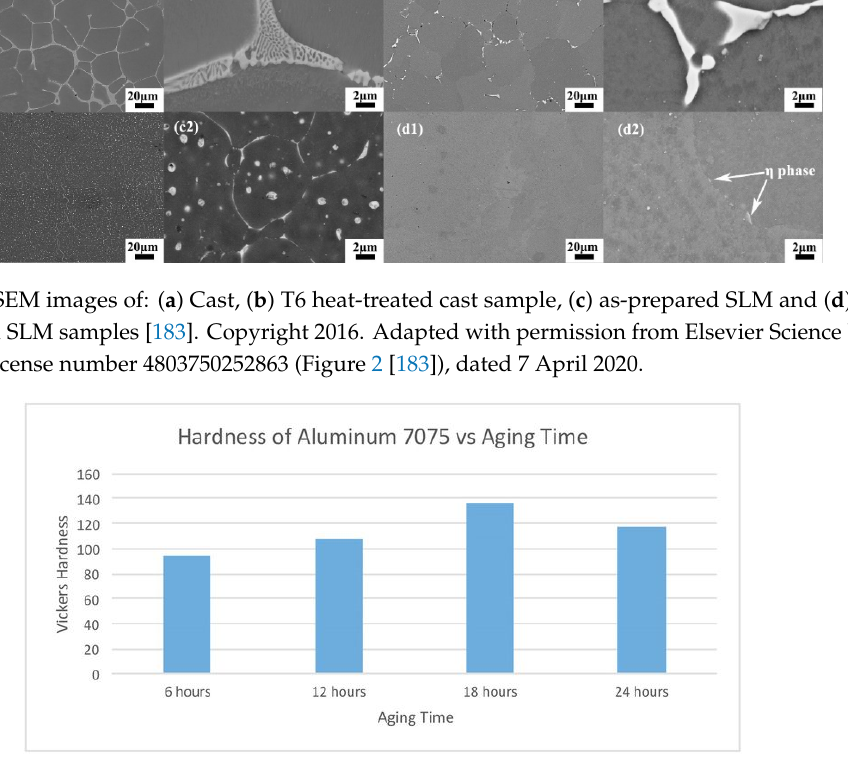
Figure 50. Variation of hardness of the SLM Al7075 alloy with aging duration [185]. Copyright 2017. Adapted with permission from Springer Nature. under the license number 4605280085008, dated 10 June 2019.